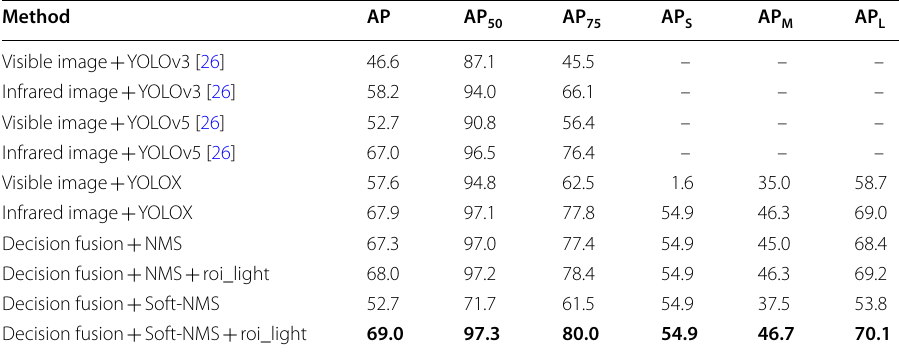
Table 1 Comparison of experimental